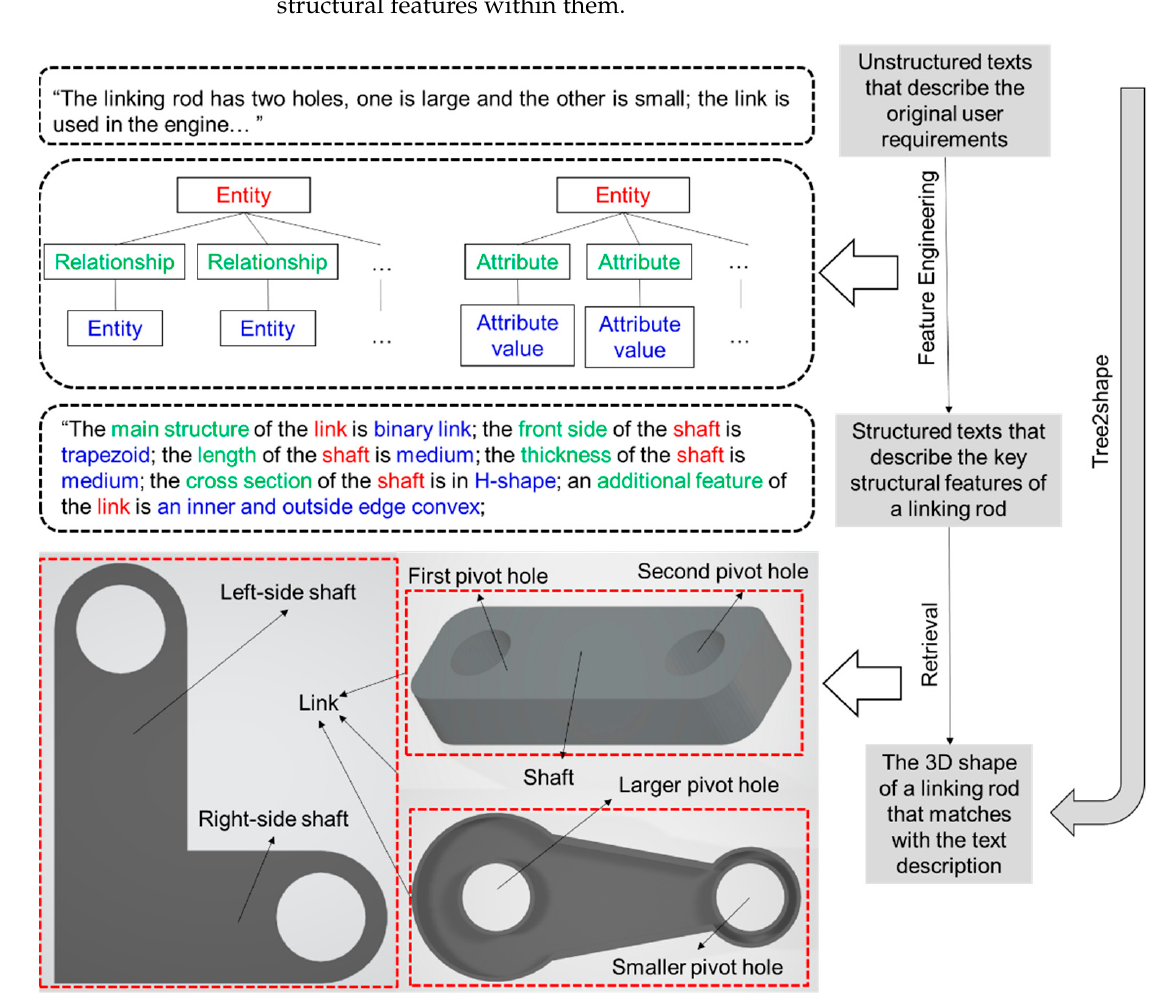
Figure 2. The main steps of feature engineering based key structural feature identification.